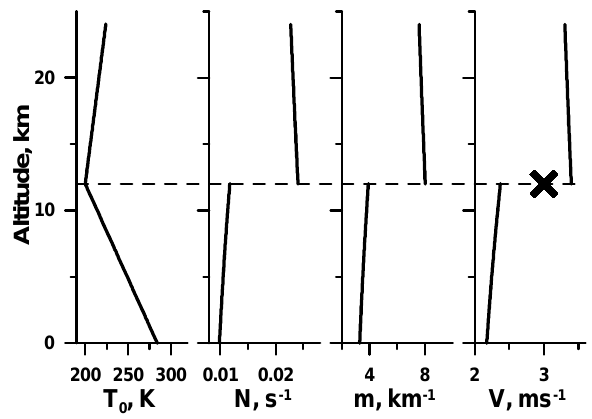
Fig. 1. Simple model of temperature profile, Brunt-V¨ais¨al¨a fre- quency, IGWs vertical wavenumber and corresponding sharp in- crease in amplitude of IGW with c=3m/s − 1 (from left to right, re- spectively). Cross shows the IGW breaking